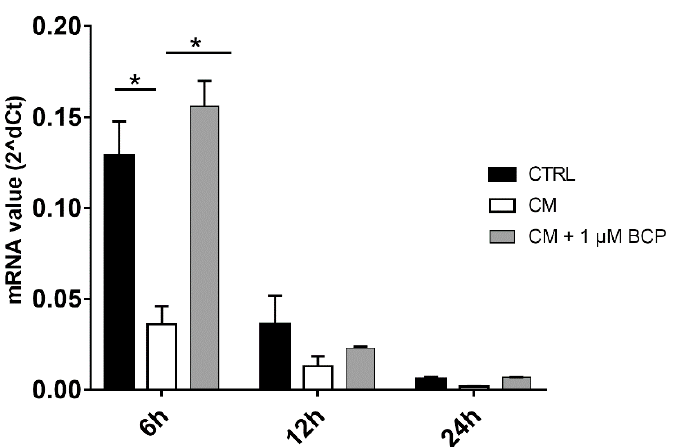
Figure 5. PPAR- γ expression of chondrocyte cultures exposed to U937 CM in the presence or absence of BCP. Human chondrocytes were exposed for 24 h to CM of activated U937 and then cultured in the presence or absence of 1 µ M BCP. RNA transcript levels for PPAR- γ were evaluated by qPCR at 6, 12 and 24 h after treatment. Statistical differences are based on one-way ANOVA test, and data are expressed as mean ± SE obtained from three independent experiments. CTRL: untreated cells; CM: cell treated with CM of activated U937 cells. * p < 0.05.